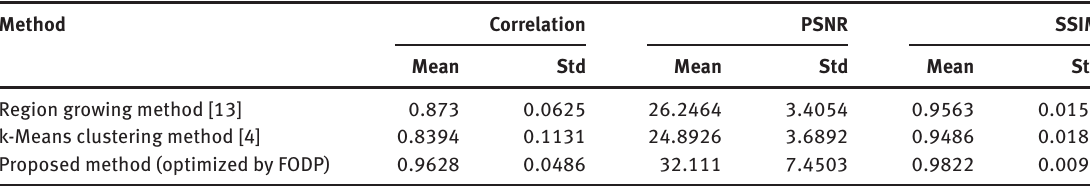
Table 7: Performance Evaluation Results